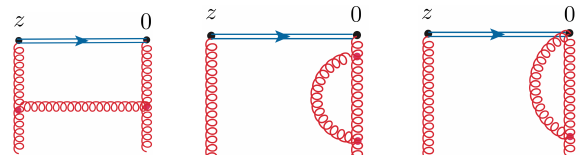
Figure 2: Box diagram and gluon self-energy-type insertions into the right